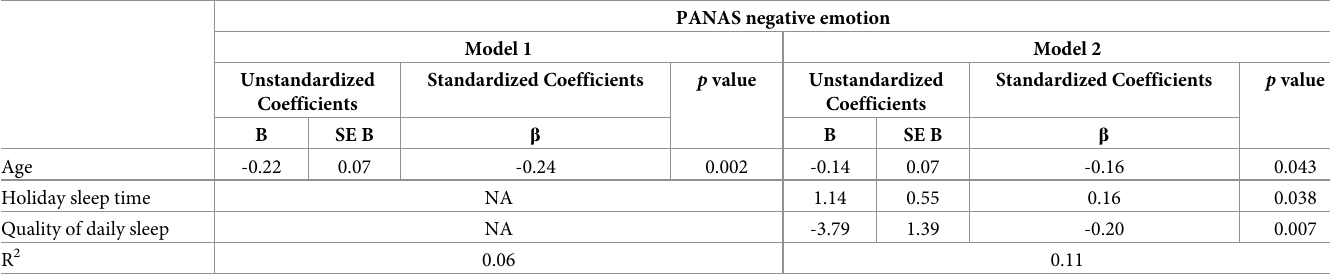
B = Unstandardized regression coefficient, SE = Standard error, β = Standardized regression coefficient, R 2 = coefficient of determination. Model 1: LF/HF ratio during work, number of > mean +0.5 SD, number of > mean +1 SD, number of > mean +2 SD, number of > mean +3 SD, number of < mean -0.5 SD, number of < mean -1 SD, number of < mean -2 SD, number of < mean -3 SD, age, and sex. NA, not applicable.